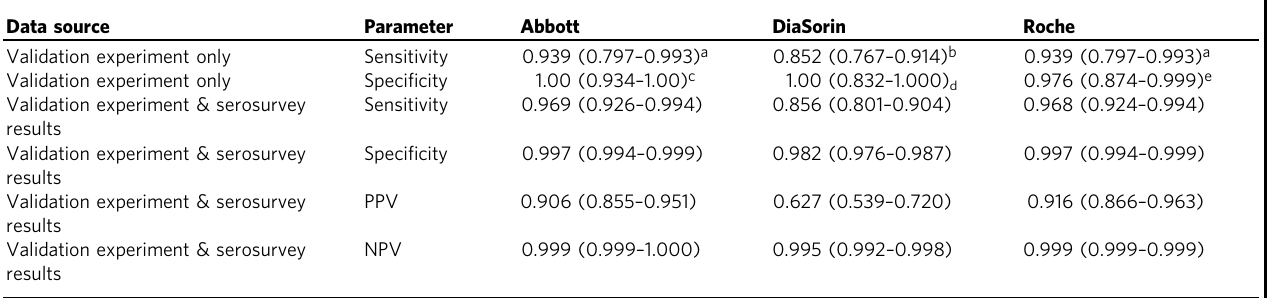
Table 3 Assay-speci fi c performance estimates.